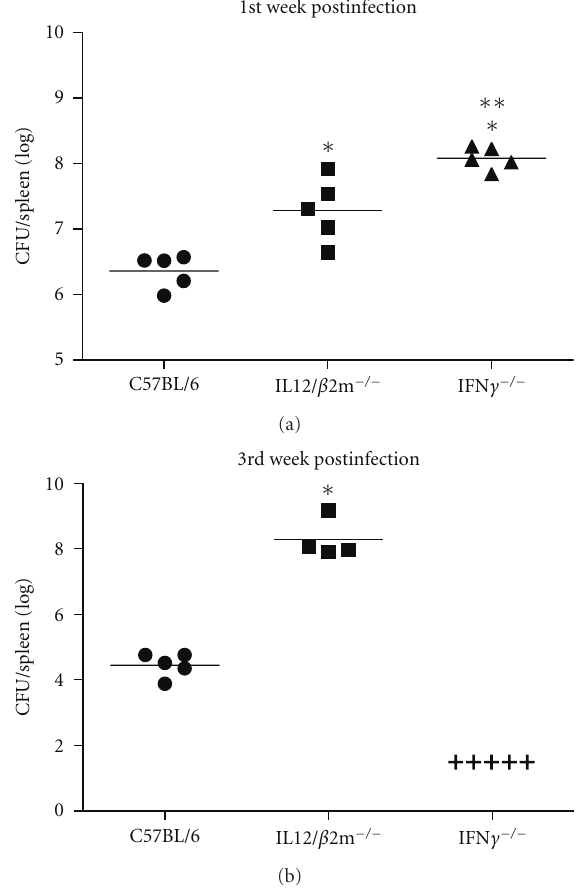
Figure 1: Growth of B. abortus in spleens of C57BL/6, IFN- γ − / − , and IL-12/ β 2-m − / − mice at the first (a) and third (b) week postinfection. IL-12/ β 2-m − / − , IFN- γ − / − , and C57BL/6 mice were intraperitoneally inoculated with 10 6 CFU of B. abortus S2308. (+) This symbol shows that all IFN- γ − / − mice died before the CFU count at the third week postinfection. Data are expressed as mean ± SD of five animals per time point. These results are representative of three independent experiments. Significant di ff erence in relation to C57BL/6 for P < 0.05 is denoted by an asterisk and in relation to IL-12/ β 2-m − / − by two